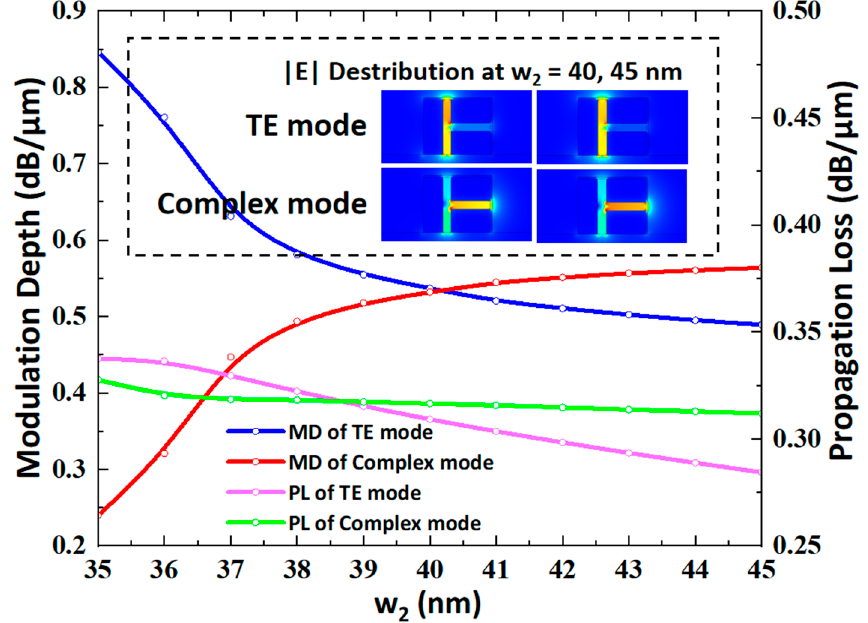
Figure 9. MD and PL of the TE mode and the complex mode as a changing relationship of w 2 .